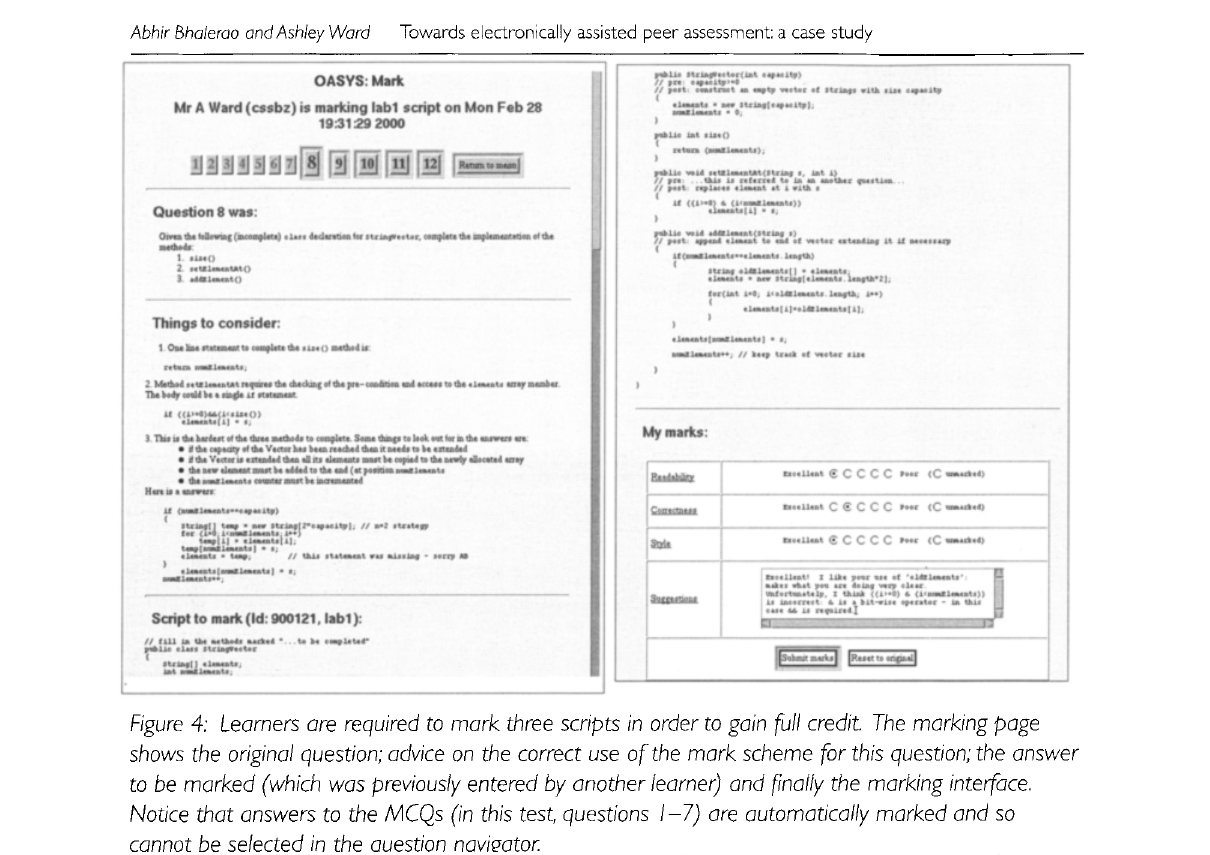
Figure 5: 'See my marks' is where leamers obtain feedback on their scripts, and can be viewed at any time from anywhere on the Intemet. Marking can also be done in learners' own time. The MCQ is jumbled the same way as the learner originally saw